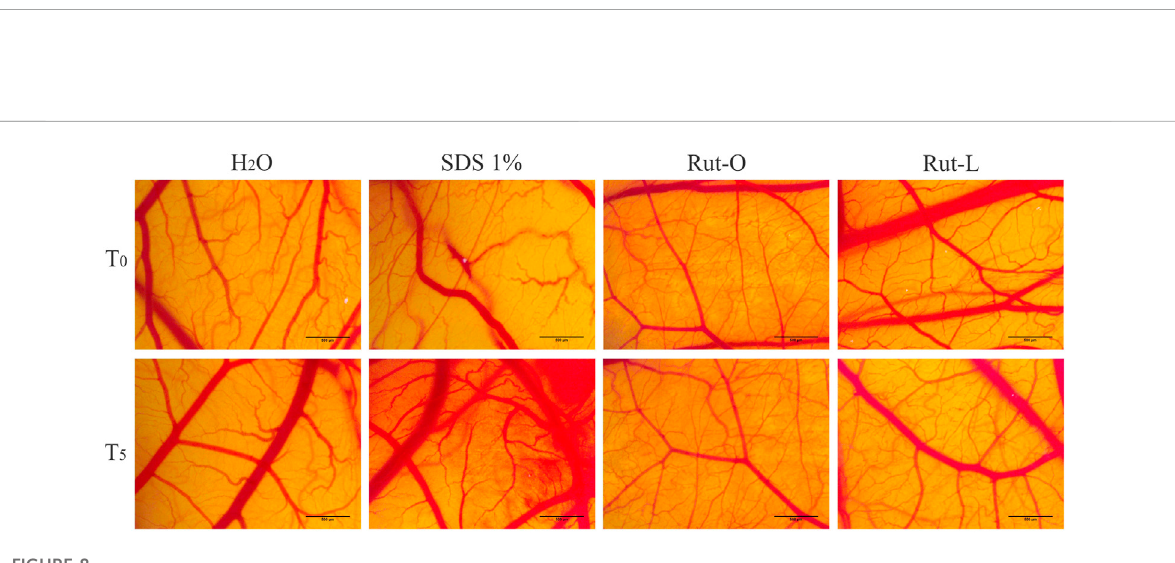
FIGURE 8 In ovo analysis of the irritant potential of RUT-O and RUT-L 100 μ M by applying the HET-CAM method. Stereomicroscopic images of CAMs inoculated with negative control — H 2 O, positive control — SDS 1% and test compounds — RUT-O and RUT-L 100 μ M. The scale bars represent 500 µm.